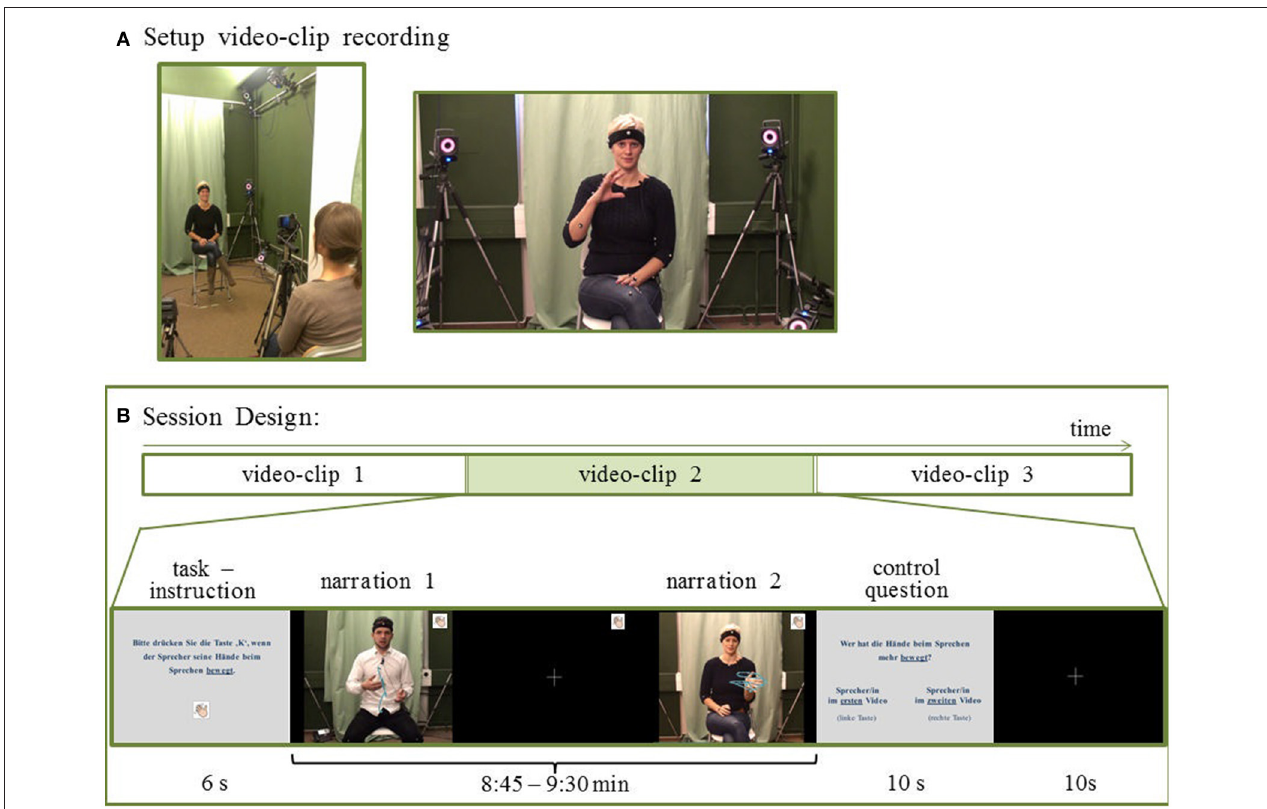
FIGURE 1 | Stimuli for behavioral and fMRI experiment. (A) After watching short movies, non-professional speakers retold the narratives on video. 24 stories were combined into 12 video clips (9min each). (B) Session design: Participants underwent 2 sessions per experiment. In one session, 3 video clips were presented. Each video clip was preceded by a task description and followed by a corresponding control question. For the behavioral part participants pressed a button according to the task. During the fMRI part they attended to the task (without pressing a button). For the CON task participants attended to conventional aspects in co-speech gestures, such as the expression of the relevance of a topic (compare “pragmatic gestures,” e.g., Payrati and Teßendorf, 2014) as indicated in the left still frame, or a depiction of a stepwise process (compare “image schemas in gestures,” e.g., Mittelberg, 2013a) as displayed in the right still frame. For visualization purposes the complete hand movement is indicated here by motion capture trajectories (blue lines). The trajectories were not displayed during the experiments. Written consent was obtained from the participants for publication of this